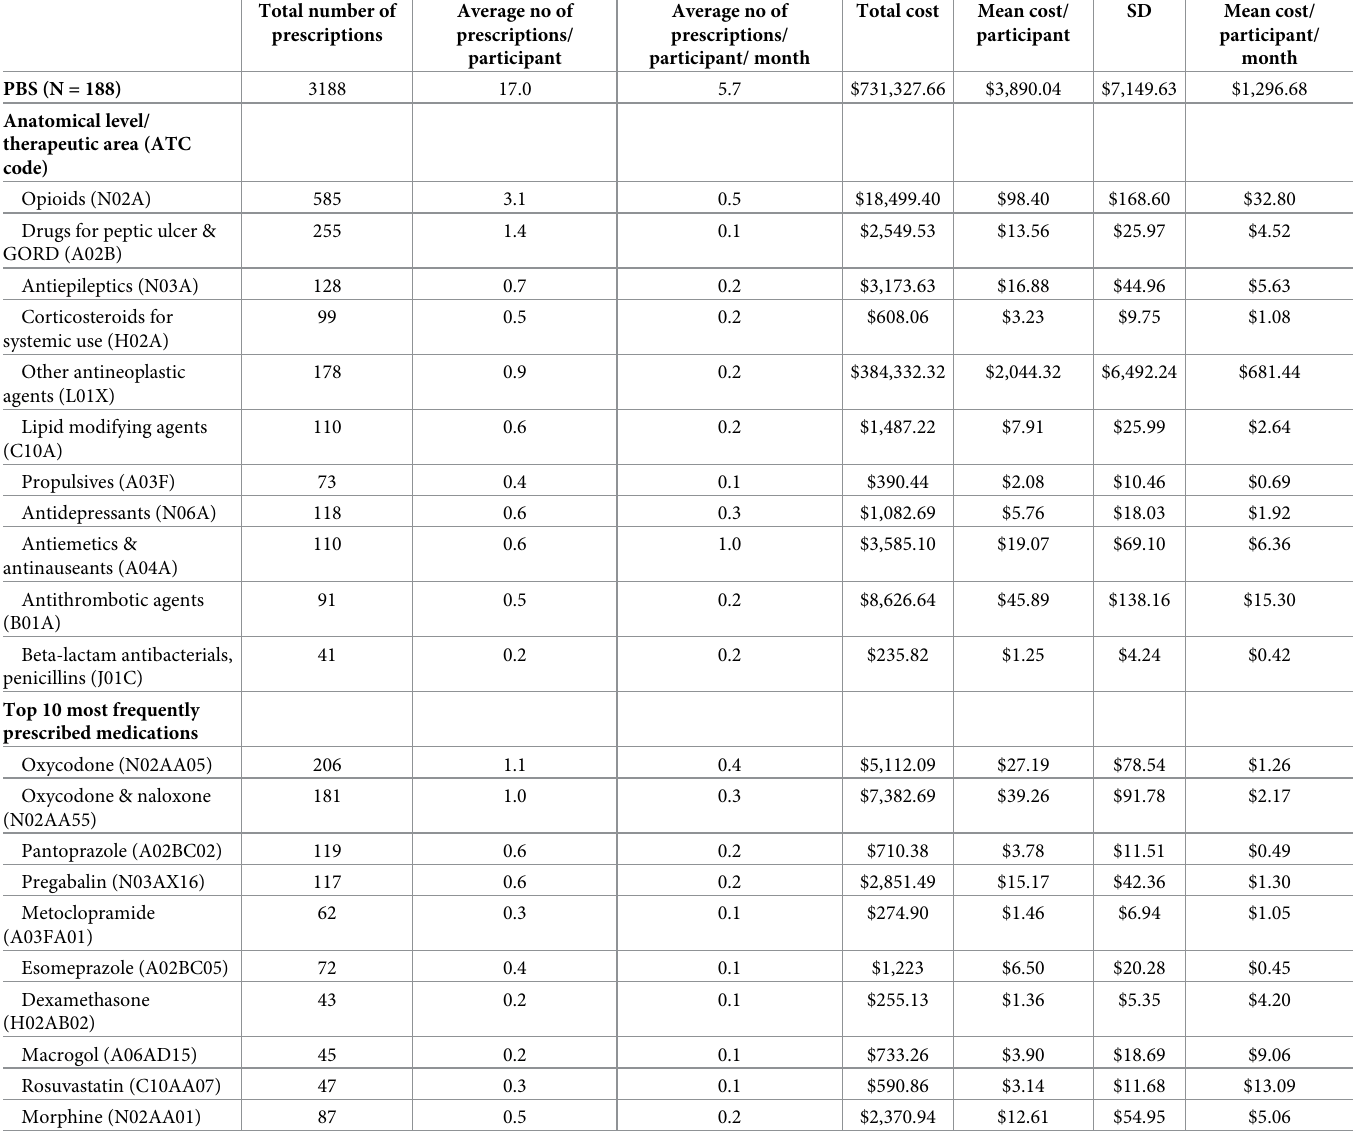
Table 3. Types and costs of medications prescribed in the three months prior to